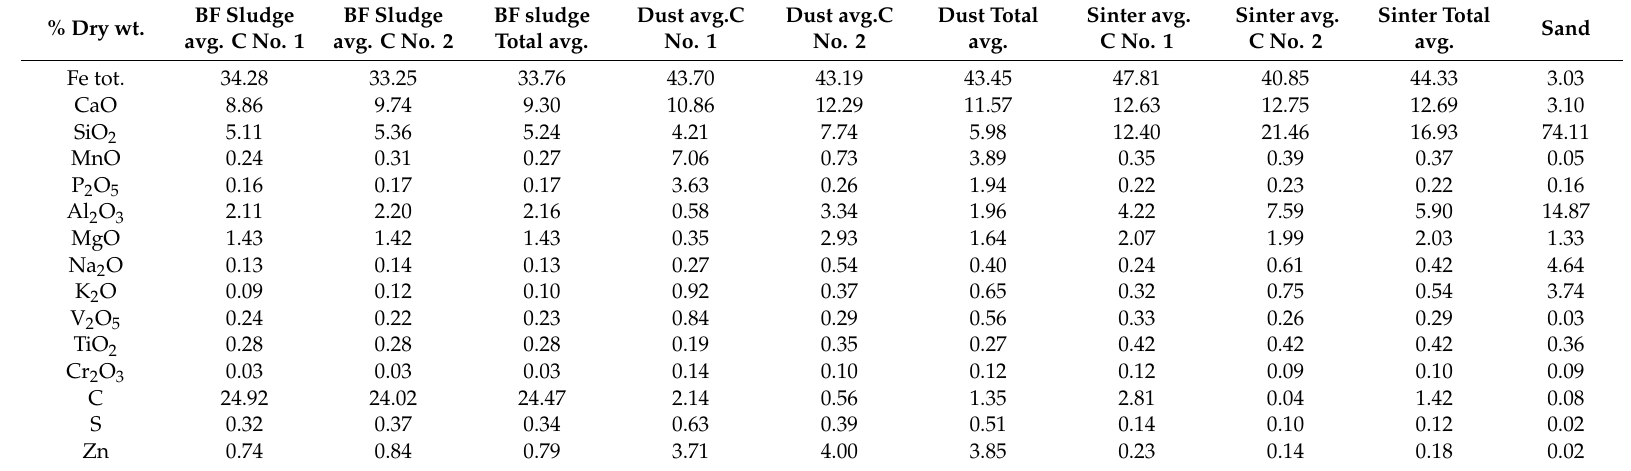
Table 1. Average chemical analyses of the BF sludge, generated OXYFINES dust and sinter as well as the sand used in sandboxes from campaigns (C) No. 1 and 2. % Dry wt.